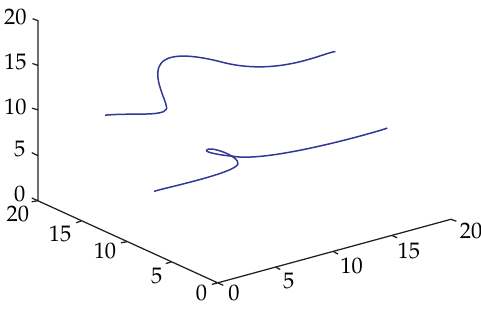
Figure 7.2 . The loop-shaped soliton on a vortex filament at τ/ ˆ κ = 0 . 23 ( bottom ) and τ/ ˆ κ = 1 . 1 ( top )